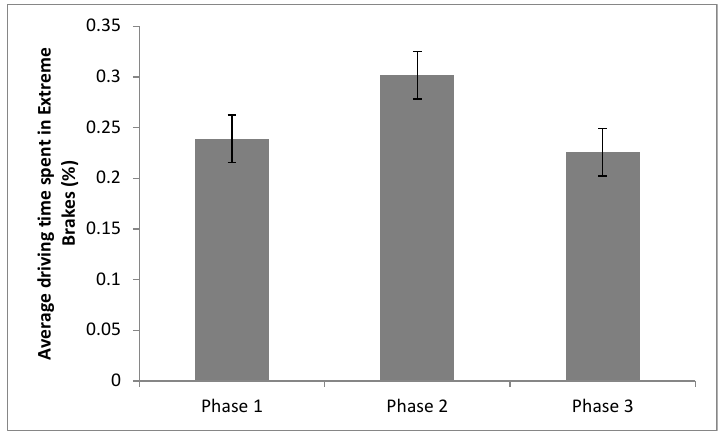
Figure 3. Average percentage of driving time in Extreme Brakes.